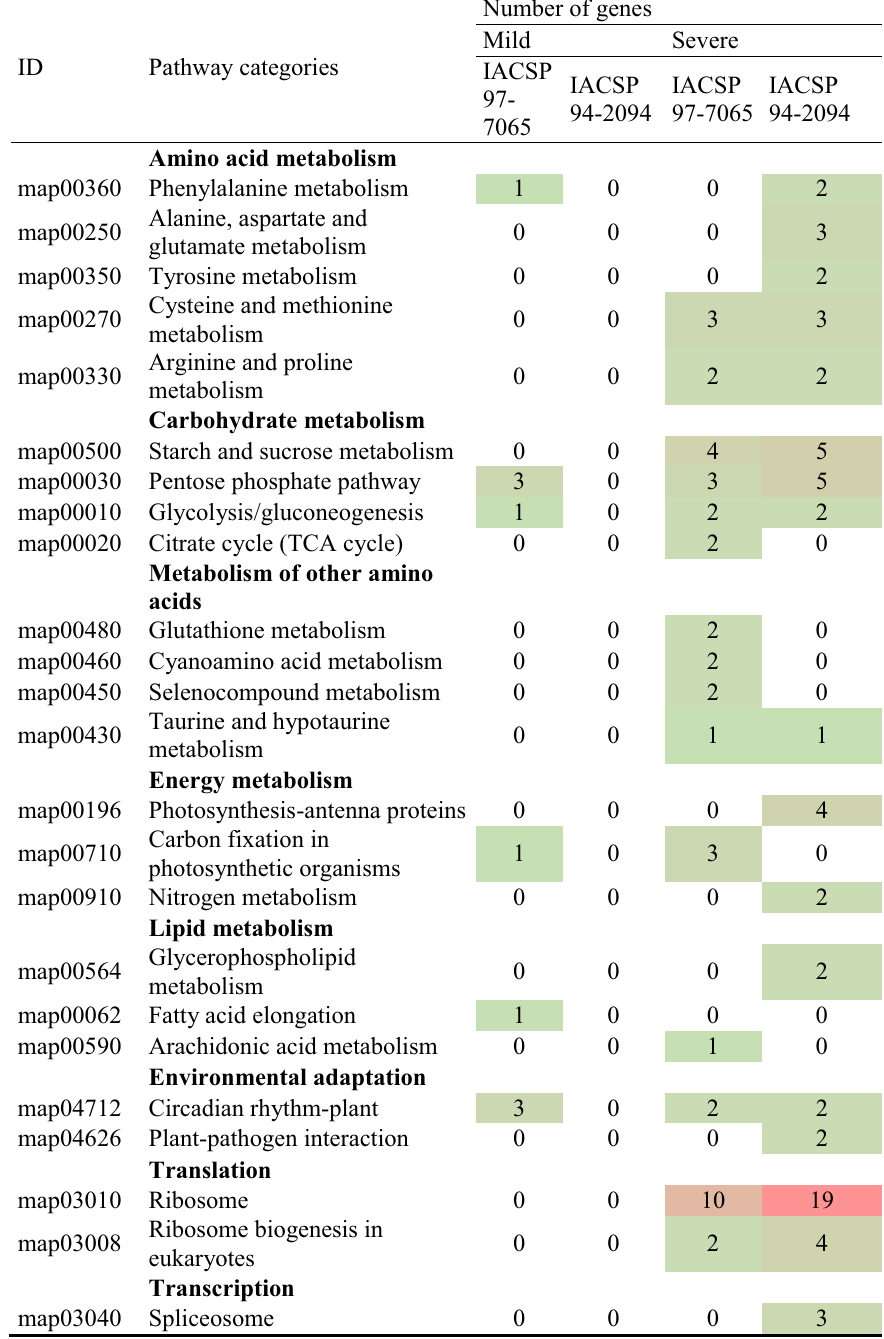
Table 1. KEGG pathway categories. Significant enriched KEGG categories represent differentially expressed genes of ‘IACSP97-7065’ and ‘IACSP94-2094’ genotypes under mild and severe drought stress ( p ≤